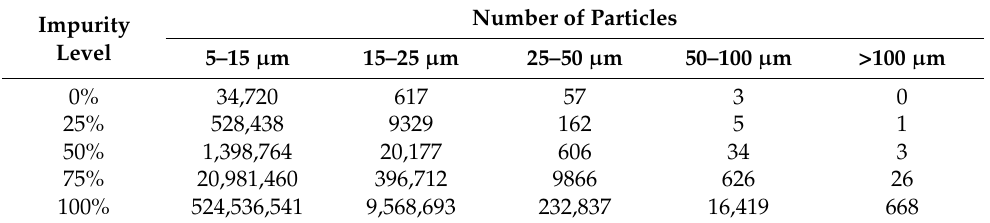
Table 5. Number of particles found in the oil according to NAS 1638